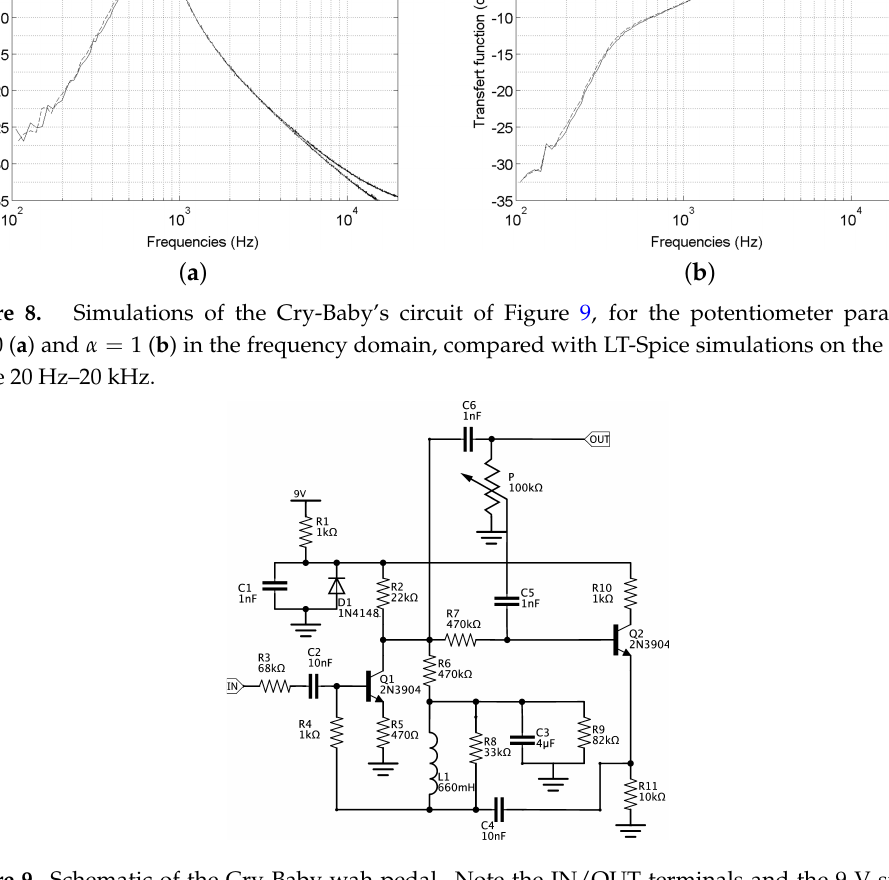
Figure 9. Schematic of the Cry-Baby wah pedal. Note the IN/OUT terminals and the 9 V supply. The potentiometer P controls the